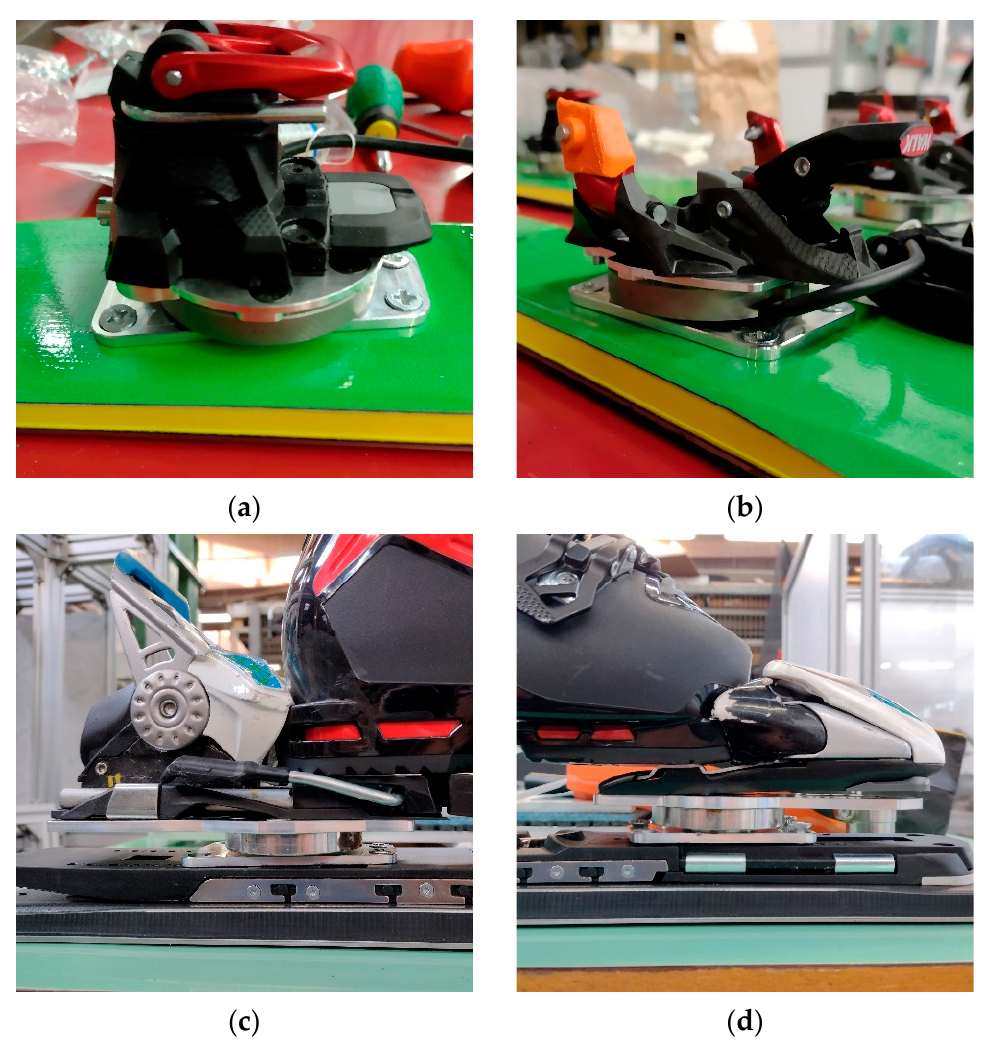
Figure 1. Load cells and plates connecting skis to ski bindings: ( a ) ski touring, rear piece; ( b ) ski touring, front piece; ( c ) alpine ski, rear piece; ( d ) alpine ski, front piece.